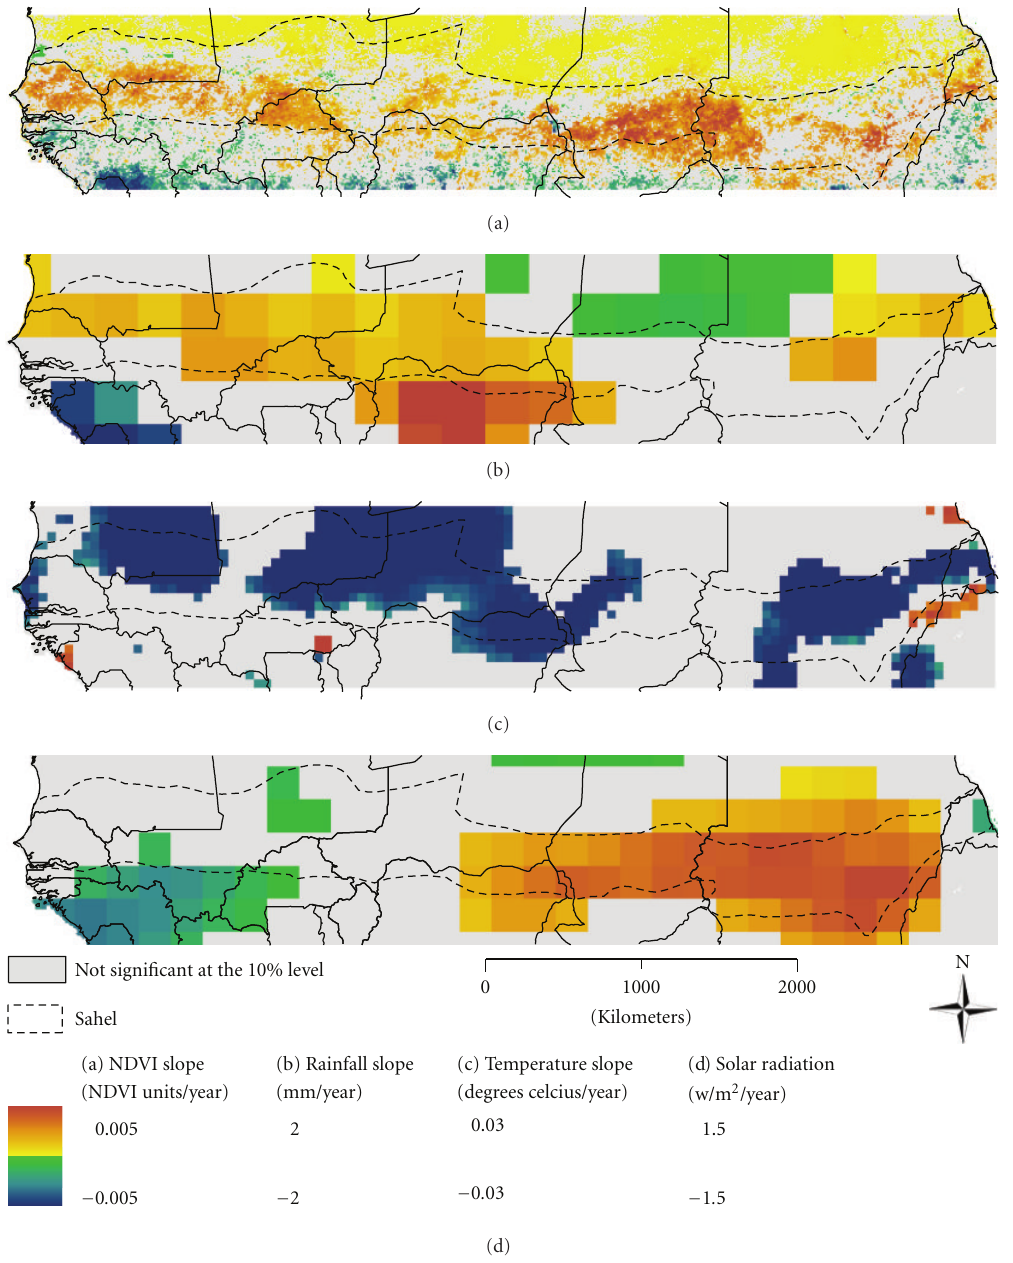
Figure 6: STA amplitude 1 images, Sahel 1982–2007 (only slopes significant at the 10% level). Changes in the amplitude of the seasonal (a) NDVI curve, (b) rainfall, (c) air temperature, and (d) surface downward solar radiation